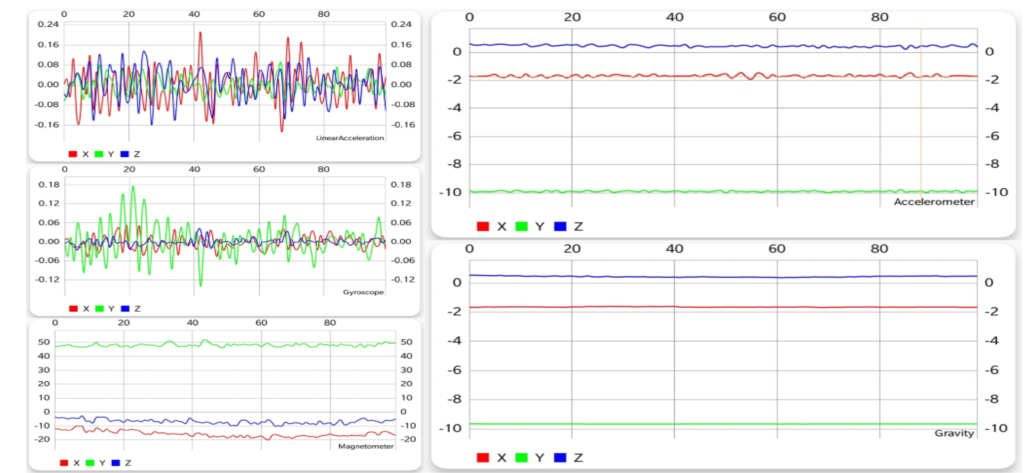
Figure 5. Graphical data gathered from each sensor while standing.